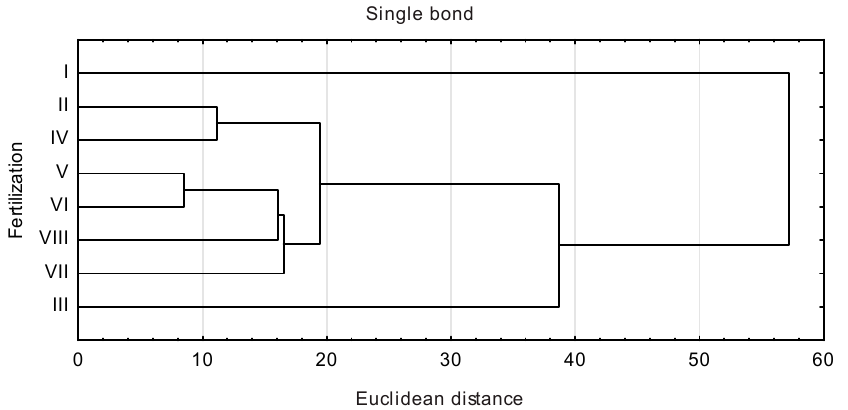
Figure 9. A dendrogram illustrating the effect of fertilization on yield and nitrogen management by maize (I–VIII—number of object, see Table 1). maize (I–VIII—number of object, see Table